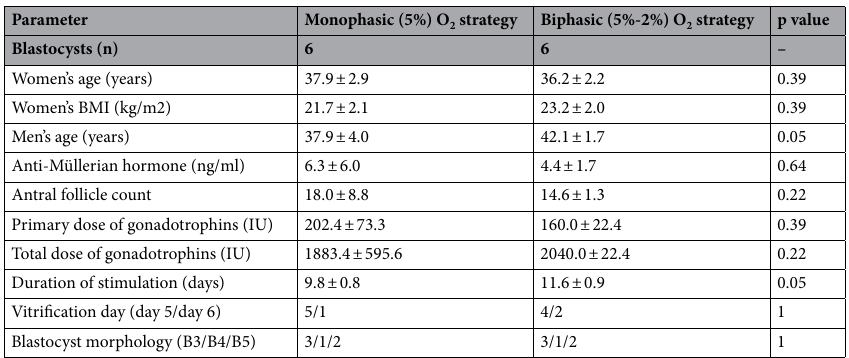
Table 3. Clinical and biological parameters of the embryos donated for the transcriptomic analysis.